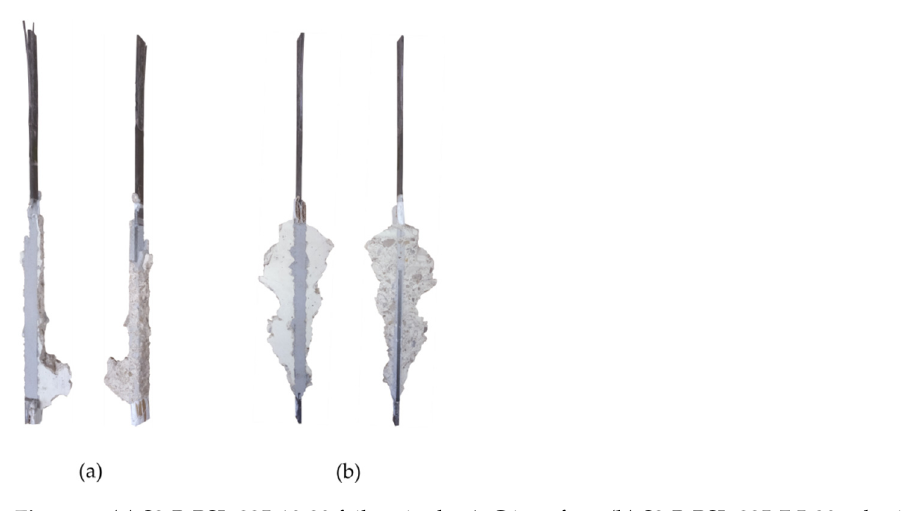
Figure 9. ( a ) S3 ‐ B ‐ PSL ‐ 225 ‐ 10 ‐ 30 failure in the A ‐ C interface; ( b ) S3 ‐ B ‐ PSL ‐ 225 ‐ 7.5 ‐ 30 cohesive failure Figure 9. ( a ) S3-B-PSL-225-10-30 failure in the A-C interface; ( b ) S3-B-PSL-225-7.5-30 cohesive failure in the concrete. in the